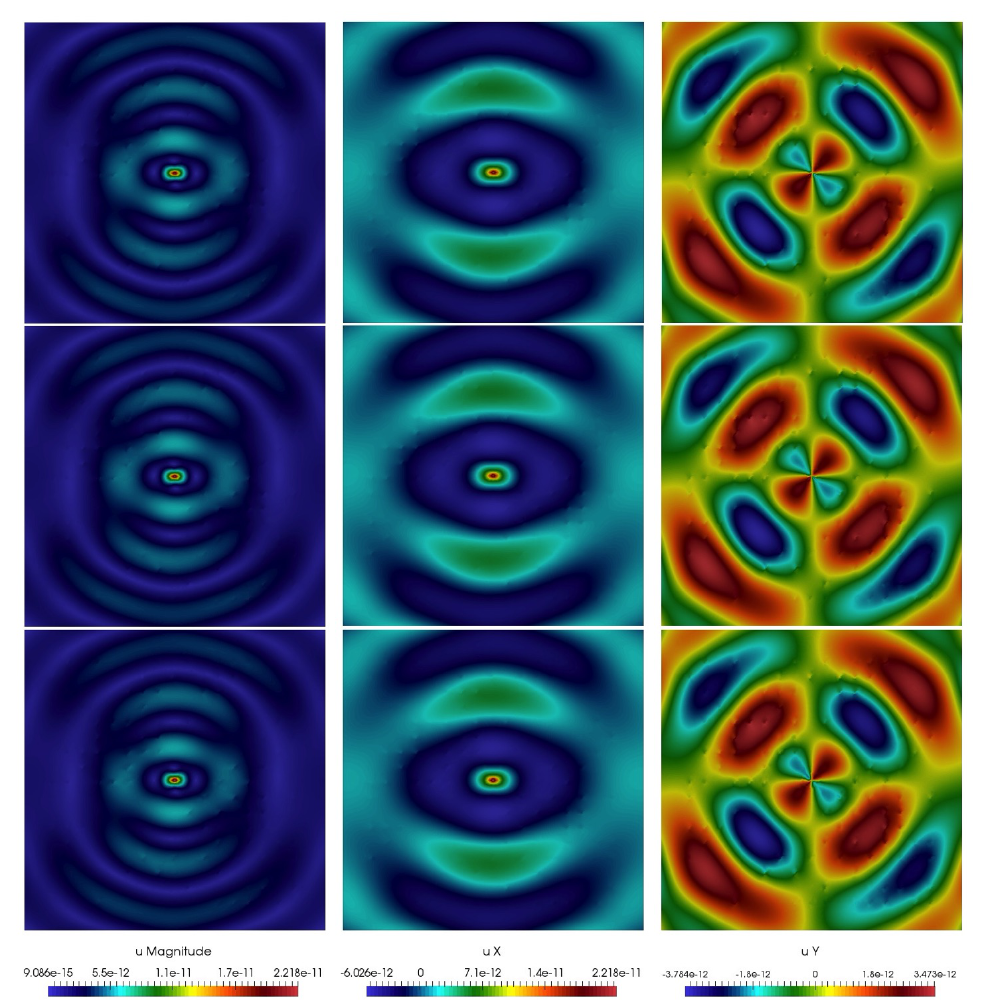
Figure 5. Numerical results for Geometry 1. Magnitude, X and Y components of displacement (from left to right). First row: reference (fine-grid) solution. Second row: multiscale solution using CG-GMsFEM. Third row: multiscale solution using